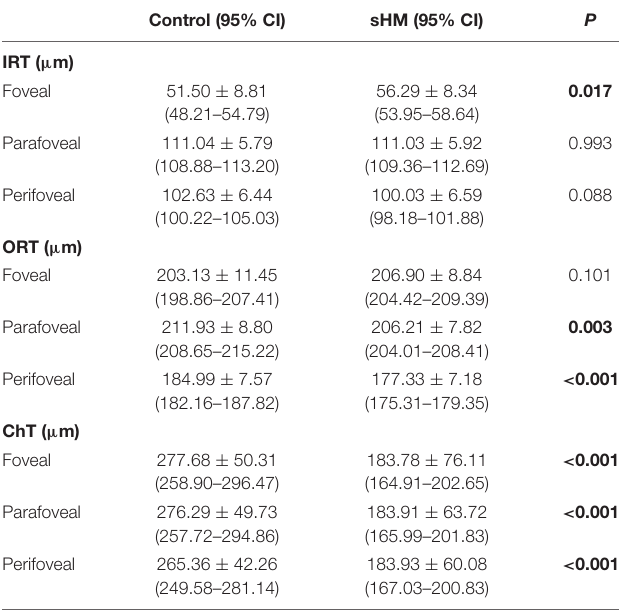
TABLE 3 | The retinal and choroidal thickness in the sHM and control groups ( µ m).